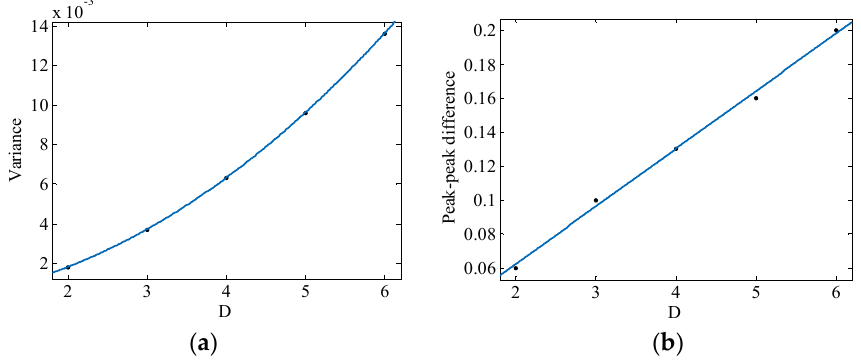
Figure 8. Relationship between characteristics of TPD and cable eccentricity: ( a ) variance, ( b ) peak-peak difference.